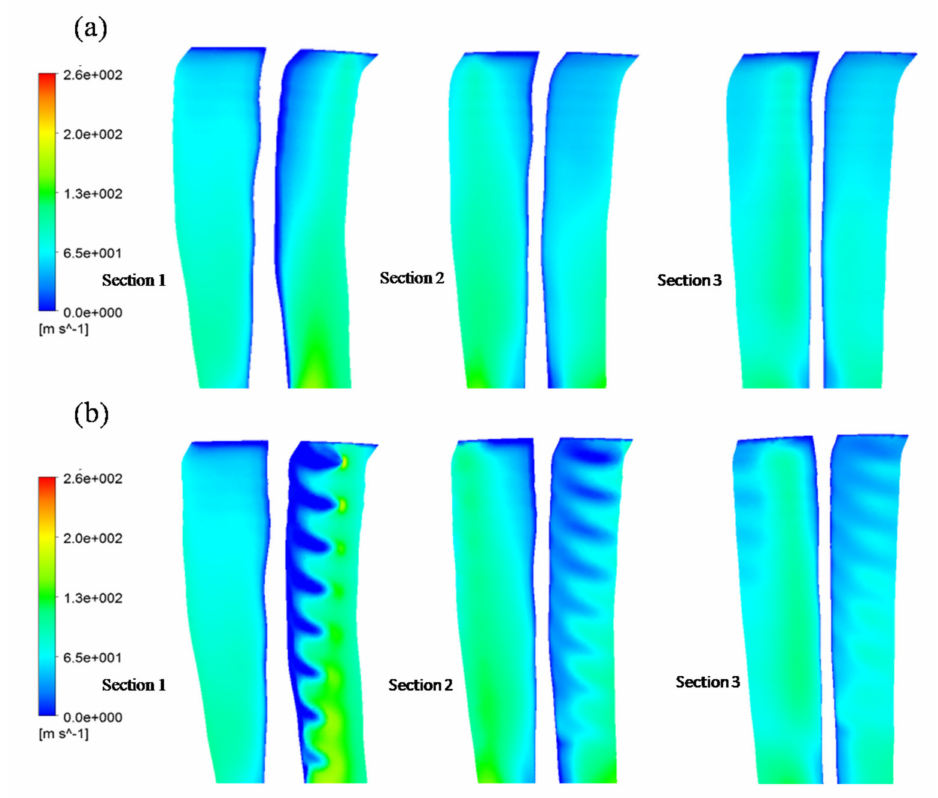
Figure 10. Cloud plots of axial velocity distribution on di ff erent sections at case 2: ( a ) original blade and ( b ) test 3.